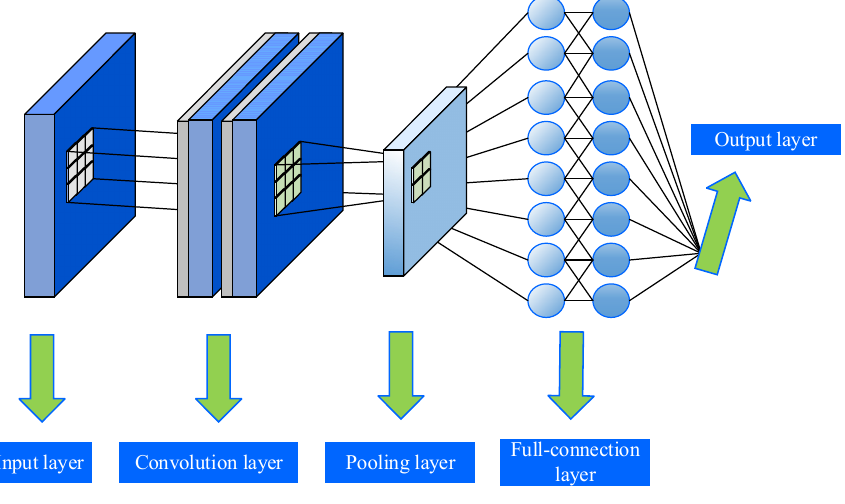
Figure 3. CNN model construction process.